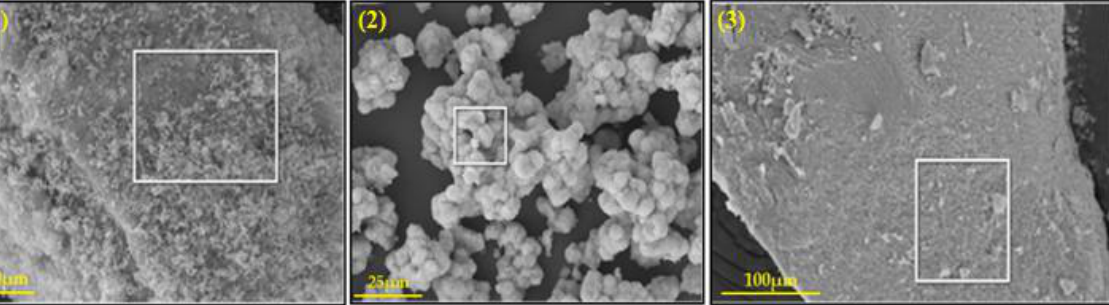
Figure 2. SEM image of catalyst - 1 ( 1 ), catalyst - 2 ( 2 ), and catalyst - 3 ( 3 ). White rectangle depicts the area of EDX data collection. Table 1. Chemical composition of nickel catalyst using